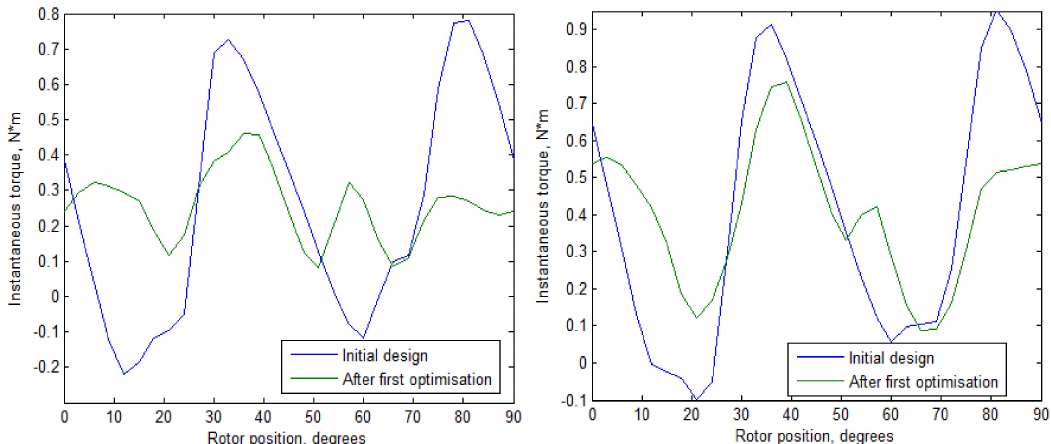
Figure 4. Torque dependencies on the rotor position before and after the optimization: ( a ) mode 1; Appl. Sci. 2020 , 10 , x FOR PEER REVIEW 7 of 16 ( b ) mode 2.